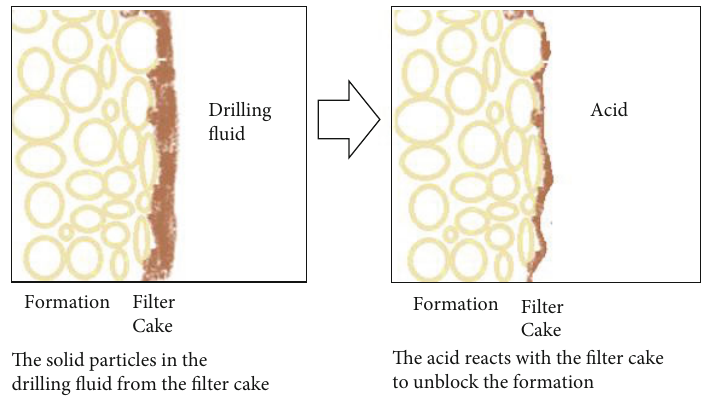
Figure 1: Sketch of the studied problem.